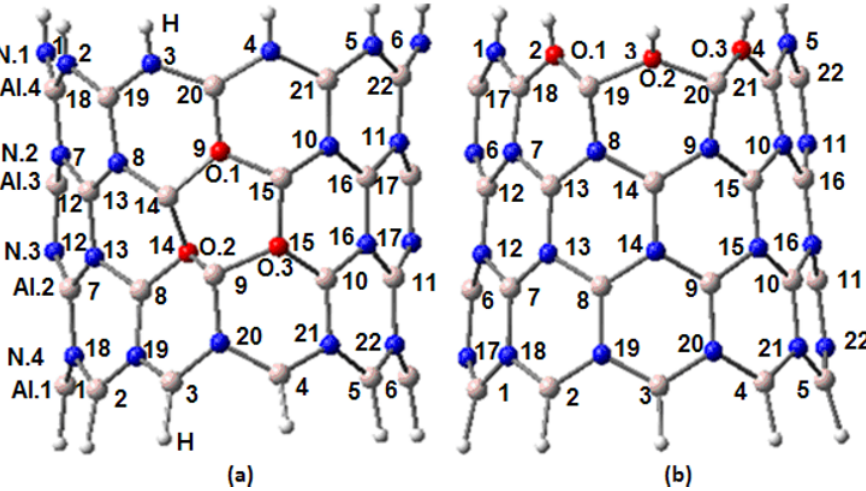
Figure 2. The 2D view of the front side of the O-decoration at the one ring (a) and at the N-mouth